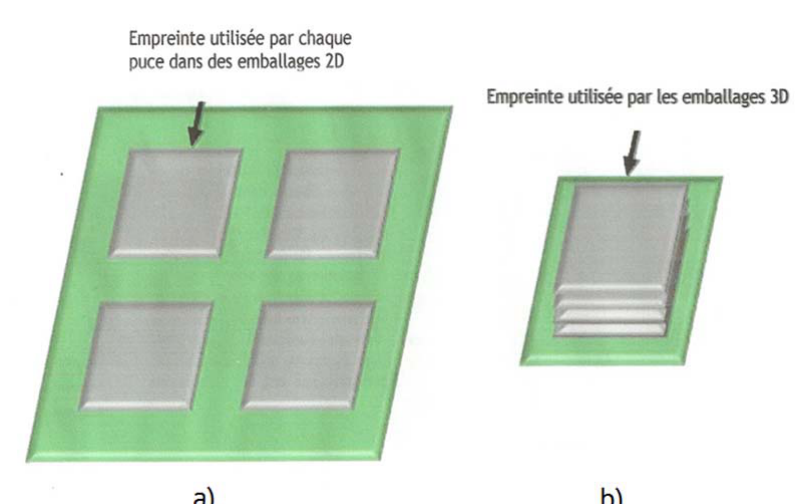
Figure 4. Schematic illustration of the difference footprint between conventional 2D packets (a) and 3D packages (b), (after [11]).